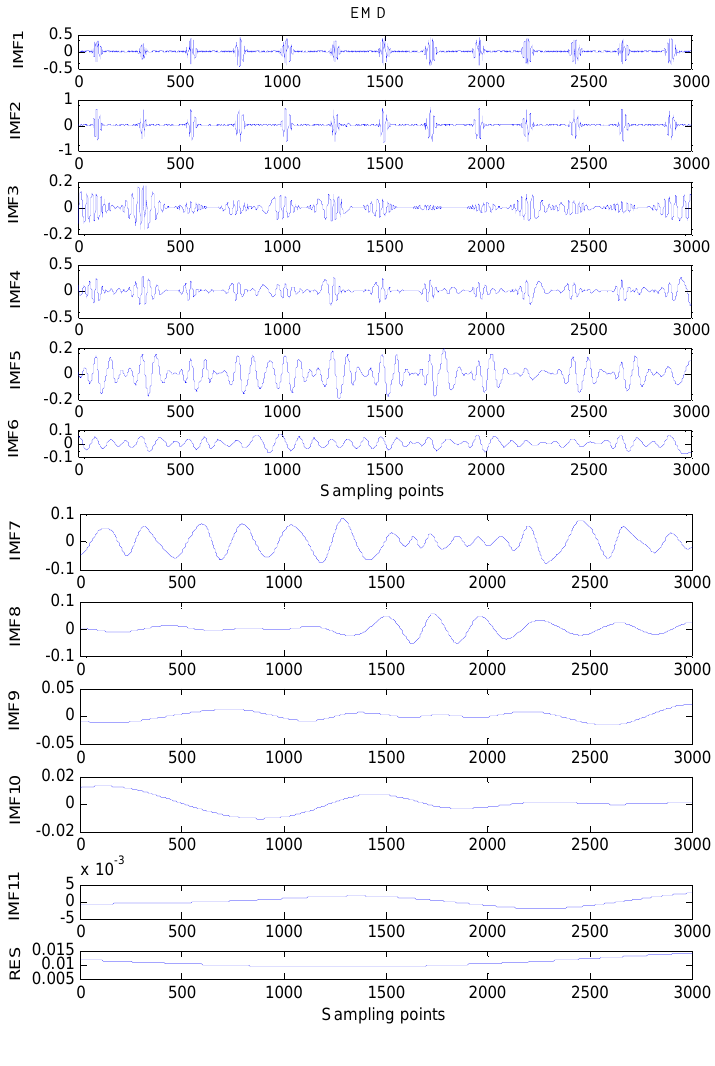
Figure 3. IMFs obtained by EMD. From top to bottom is low level IMF to high level IMF.